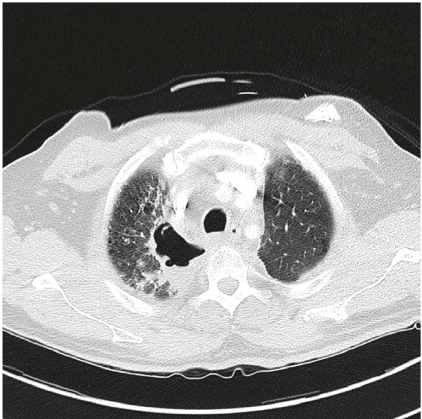
Figure 5: CT chest showing air-fluid levels within chest after ini- tiation of chemoradiation.